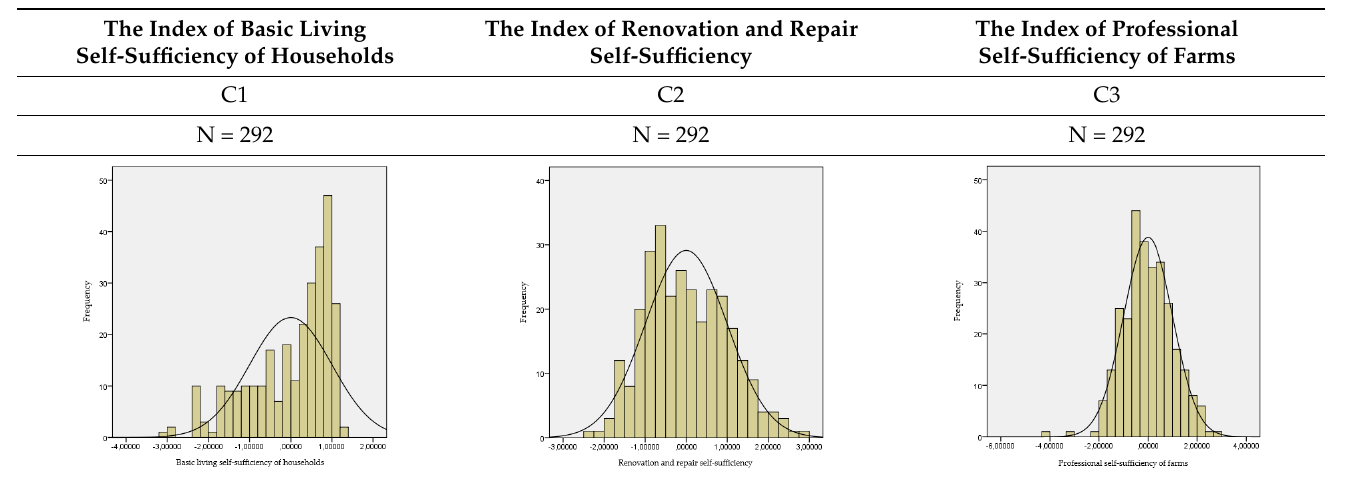
Table 8. Histograms for separated three components.